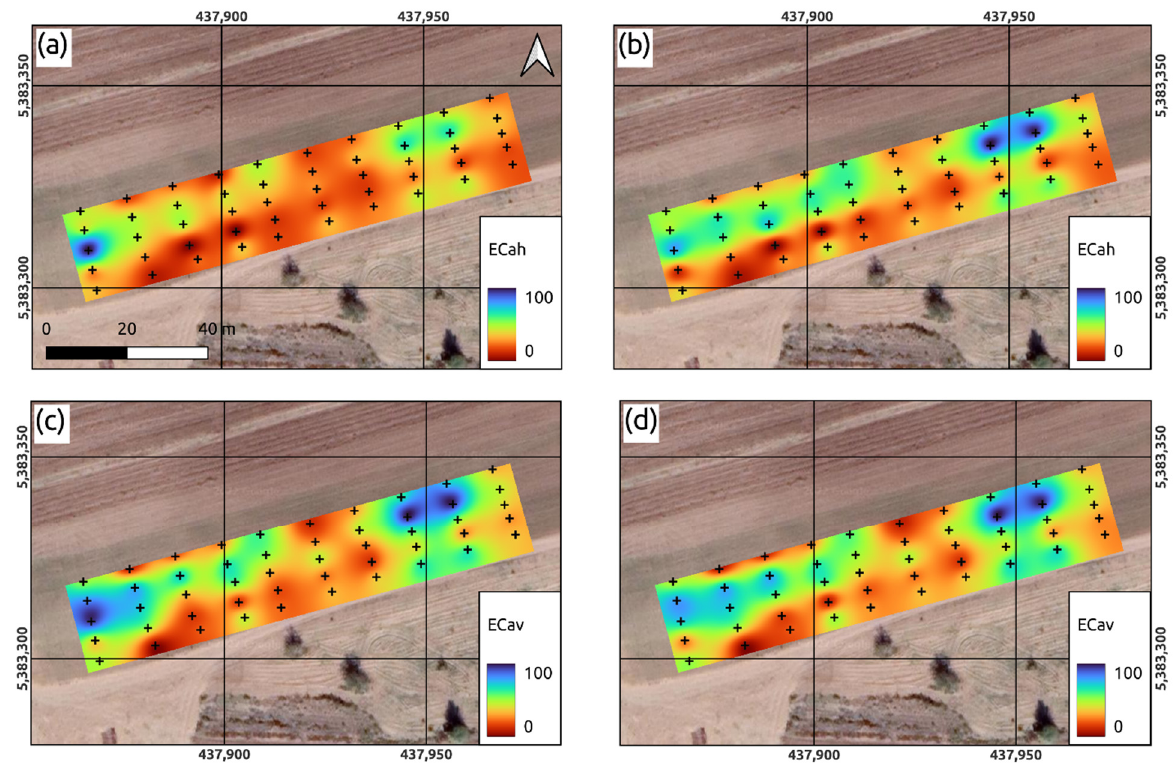
Figure 5. Interpolated plots of apparent electrical conductivity: ( a ) EC ah measured in horizontal mode within a depth of 0–15 cm; ( b ) EC ah measured in horizontal mode within a depth of 0–45 cm; ( c ) EC av measured in vertical mode within a depth of 0–90 cm; ( d ) EC av measured in vertical mode within a depth of 0–120 cm. Original EC values were rescaled to 0–100 for better visual representa- tion.